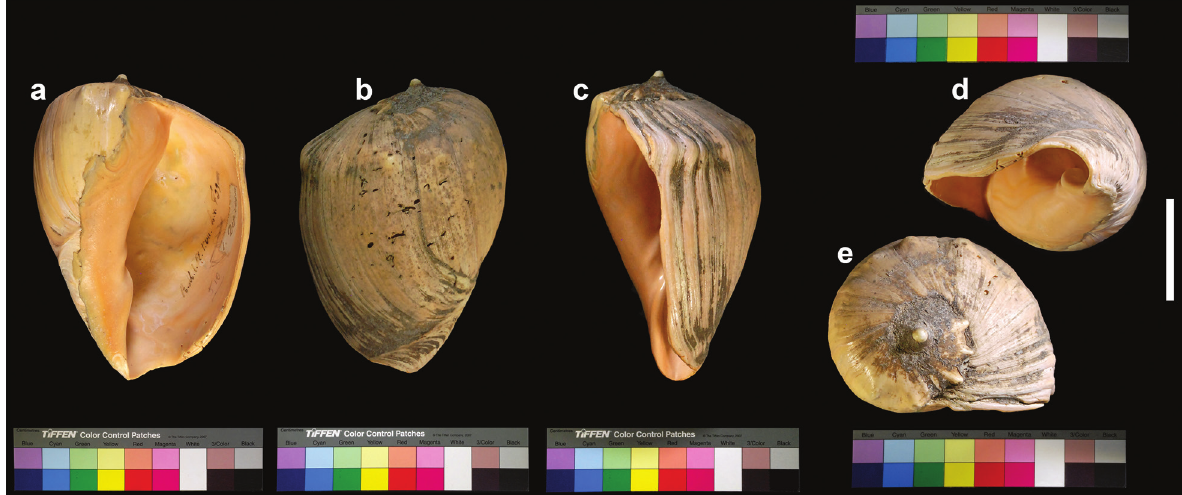
Figure 31. Holotype of Voluta colocynthis depressa , figured by Lahille (1895: pl. V, fig. 39) a Apertural view b Dorsal view c Lat- eral view d Umbilical view e Apical view. Scale bar: 5 cm.